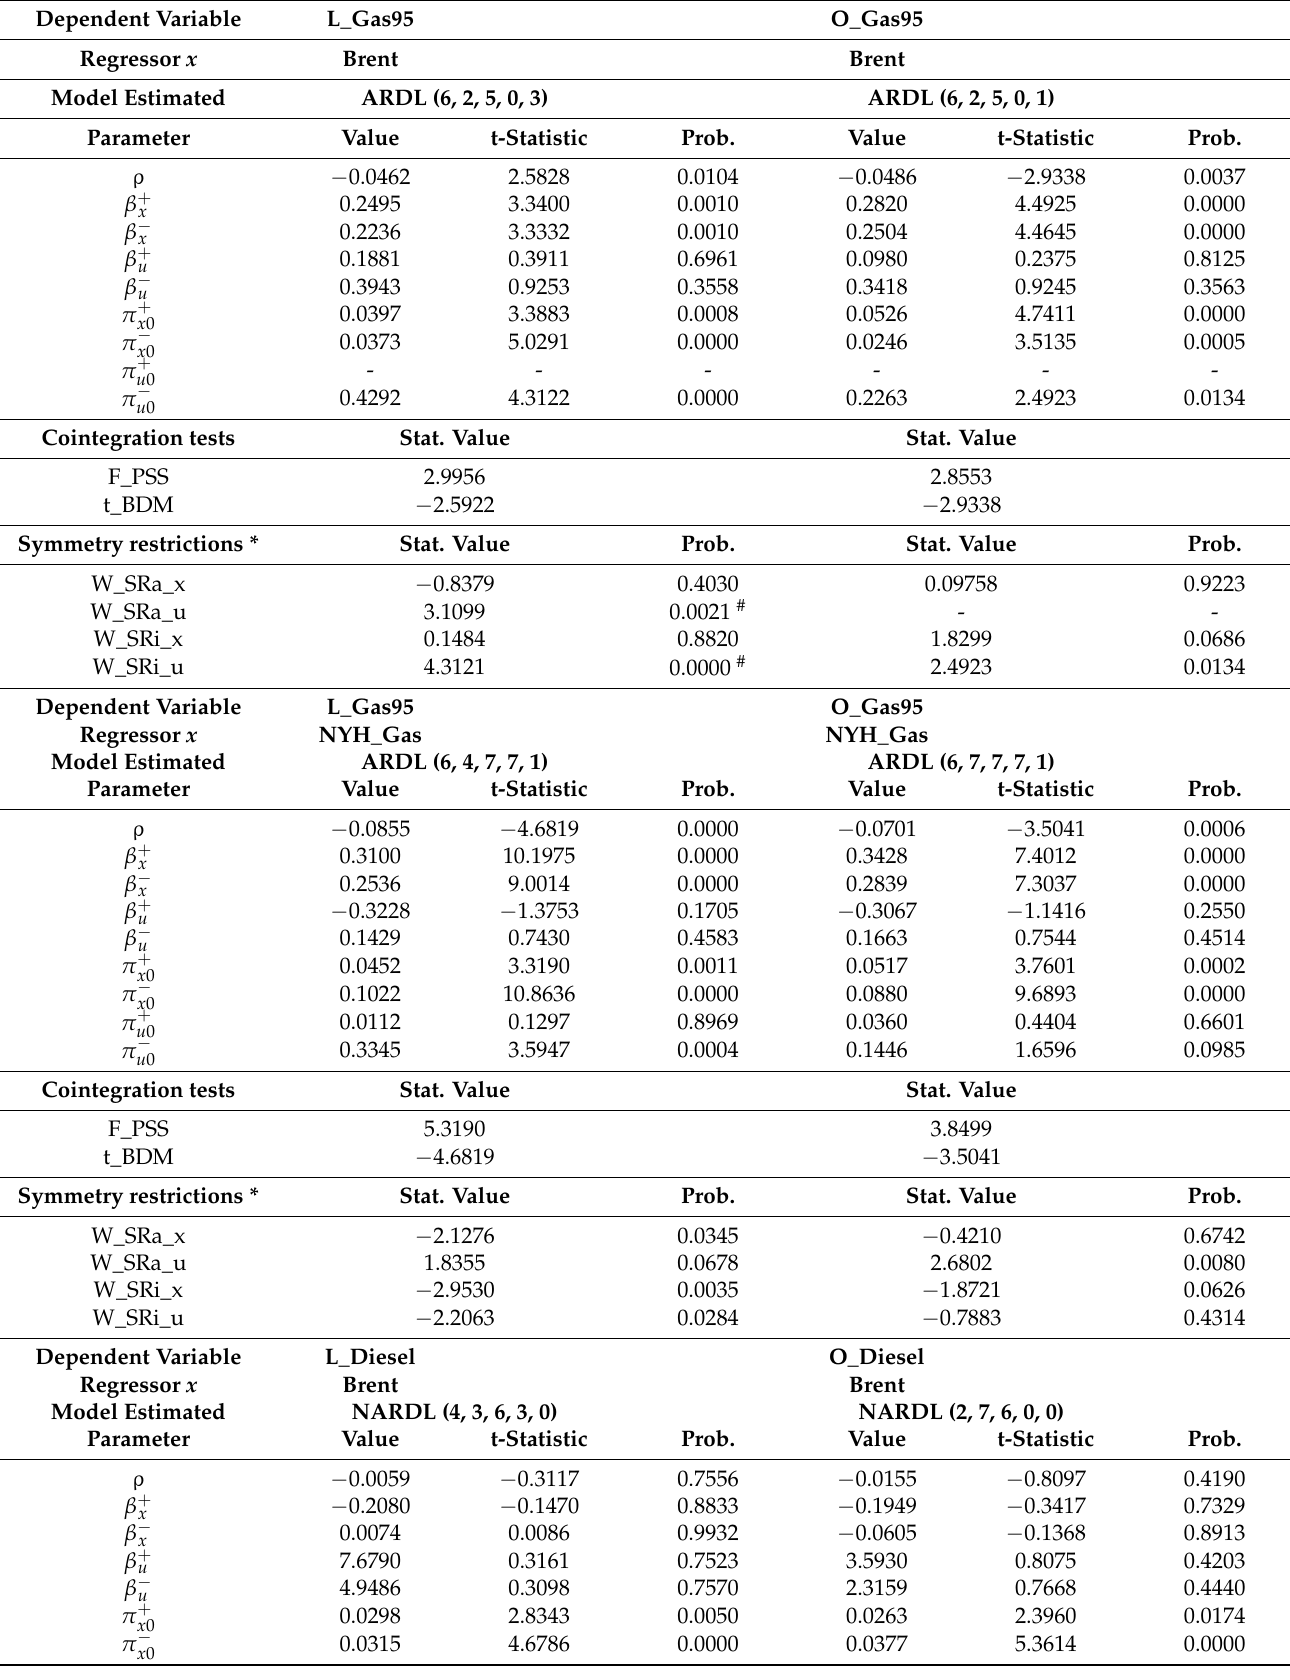
Table 8. NARDL estimation results—subsample